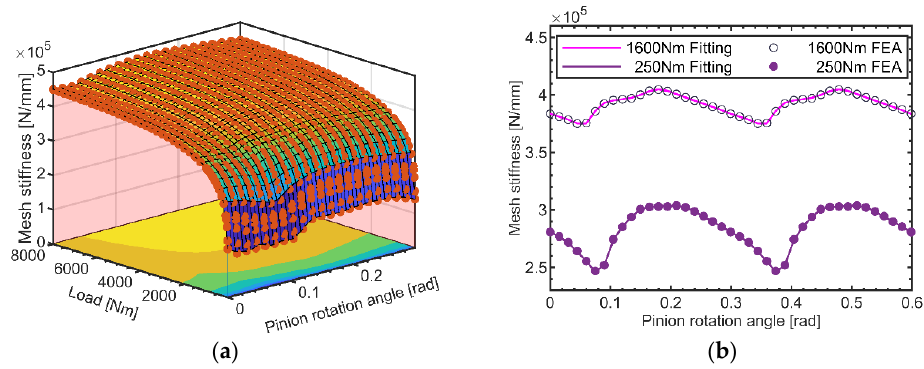
Figure 5. Mesh sti ff ness model of upper face gear: ( a ) neural network model; ( b ) veri fi cation of gen- Figure 5. Mesh stiffness model of upper face gear: ( a ) neural network model; ( b ) verification of eralization capability. generalization capability.